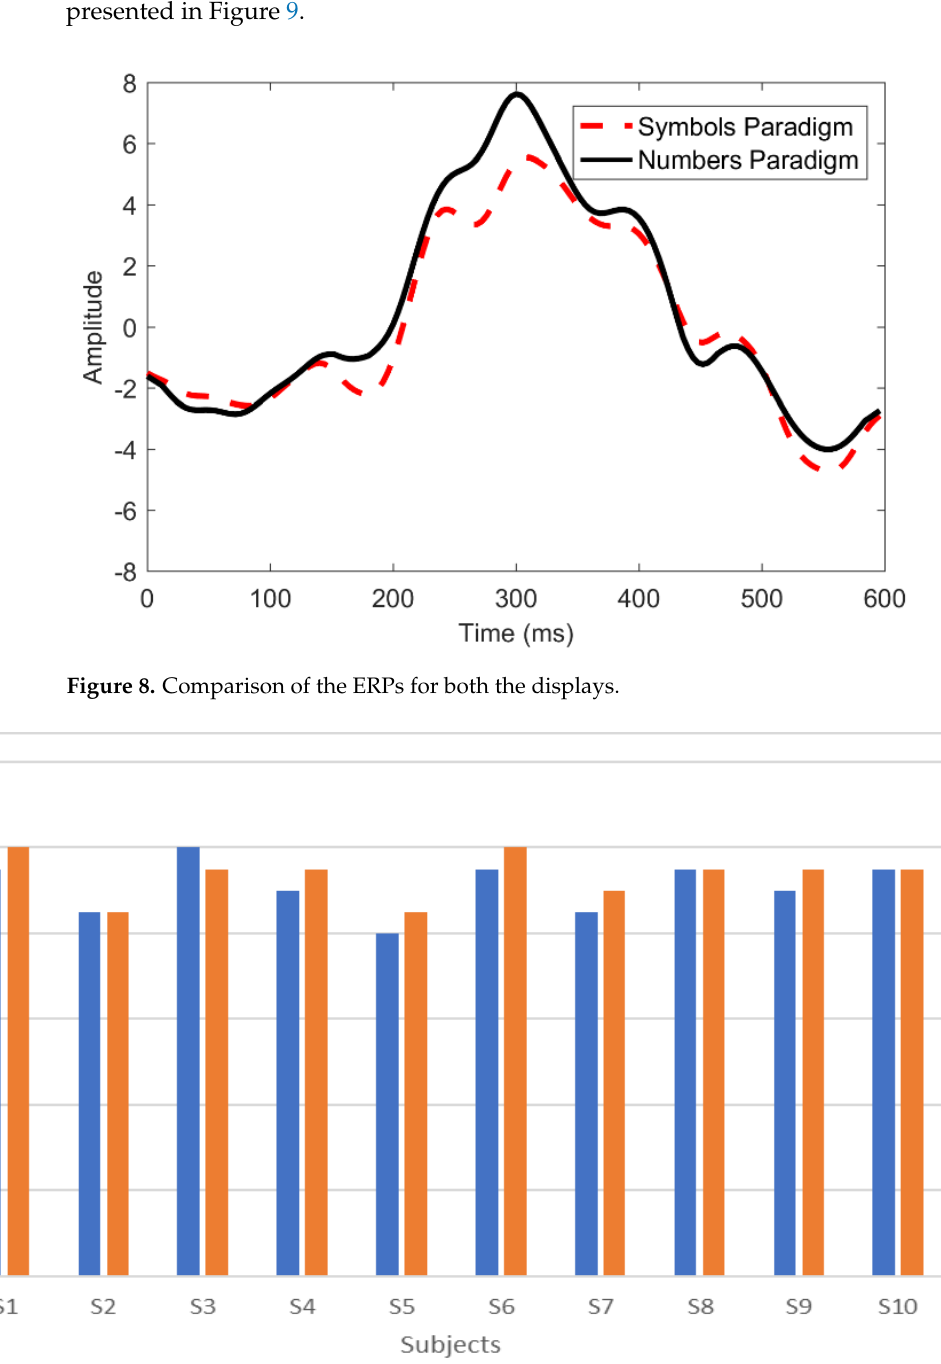
Figure 7. Waveforms for target and non − target stimuli. ( a ) Primary symbols − based display for con- trolling home appliances. ( b ) Secondary display (Numbers − based) for making phone calls.